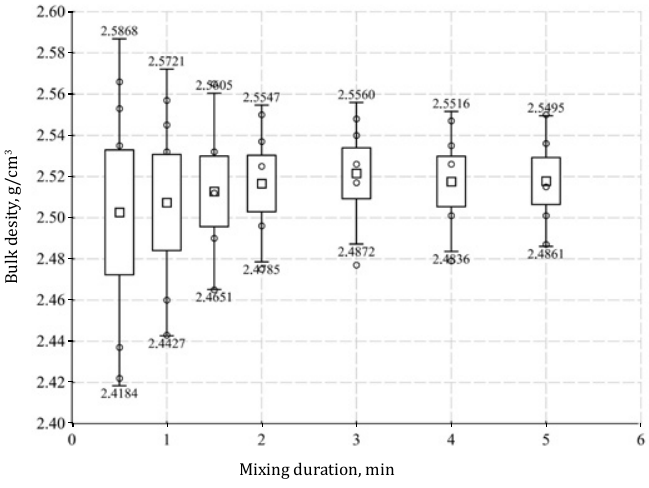
Figure 15. The effect of the mixing duration on the bulk density of the mixture containing